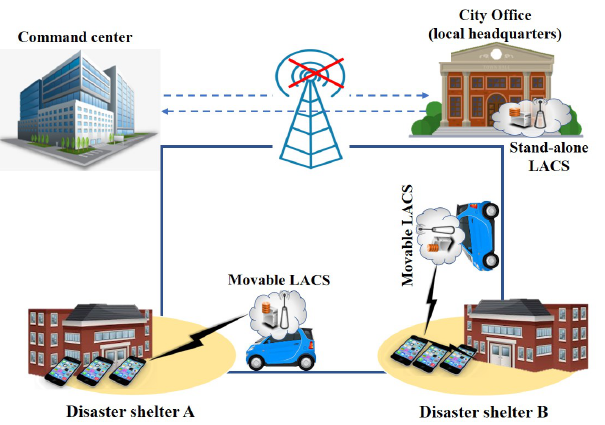
Figure 4. Information delivery/collection between users at an disaster shelter and movable LACS.